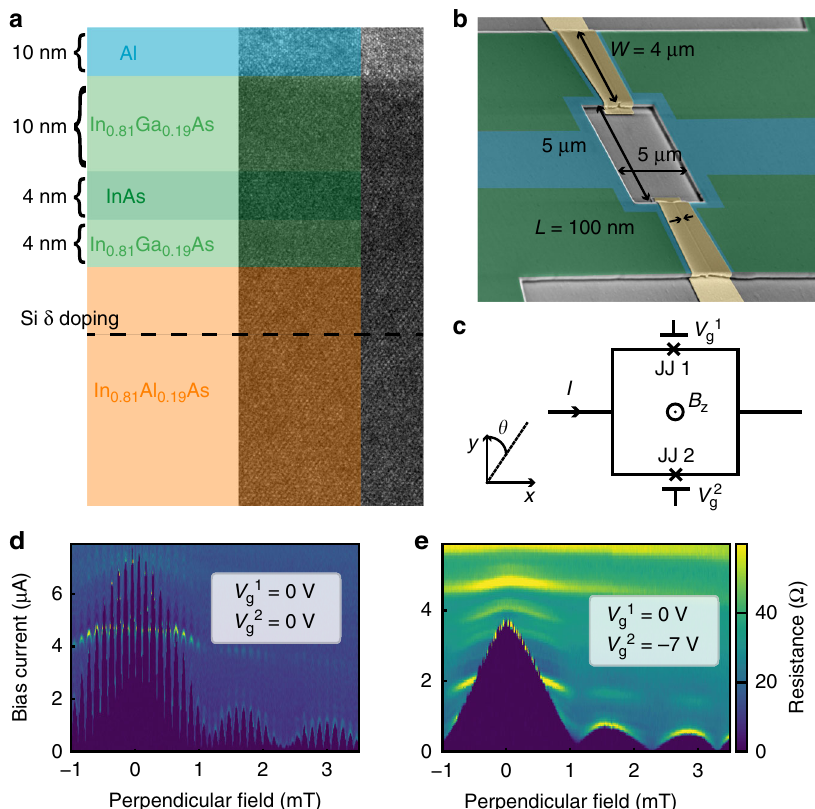
Fig. 1 SQUID consisting of two gate-tunable InAs junctions. a Sample stack description superimposed on large scale TEM image. b Colorized SEM image of a device similar to the one presented. The SQUID loop is about 5 × 5 μ m, both junctions have a gap of about 100 nm and are 4 μ m wide. c Schematic of the device. Each junction can be gated independently. The x direction is de fi ned in the plane of the sample along the current direction. d Resistance of the SQUID as a function of the perpendicular fi eld and bias current with both gates set at 0 V. Typical fast SQUID oscillation of the critical current can be seen on top of the larger scale Fraunhofer pattern of the junctions. e Resistance of the SQUID as a function of the perpendicular fi eld and bias current with V 1 at 0 V and V 2 set at − 7 V. The SQUID oscillations visible in d are completely absent and only the single junction Fraunhofer pattern is g